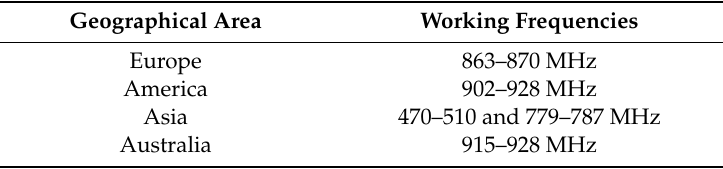
Table 1. Long Range (LoRa) frequencies for different geographical areas.